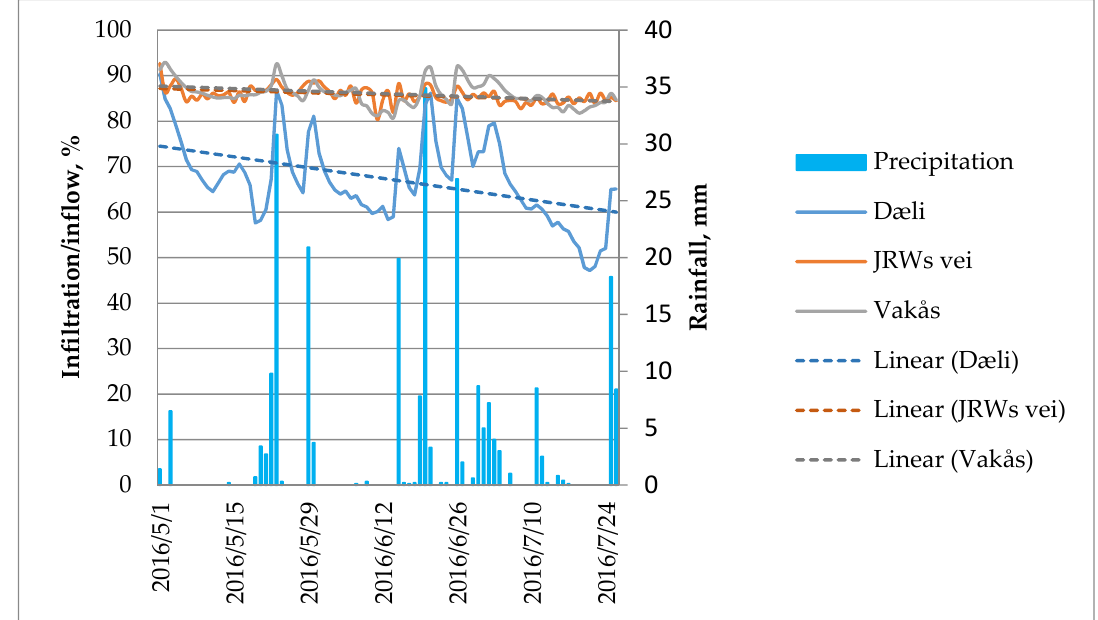
Figure 9. Calculated share of I/I-water in a wet weather period, before the implementation of the measures.